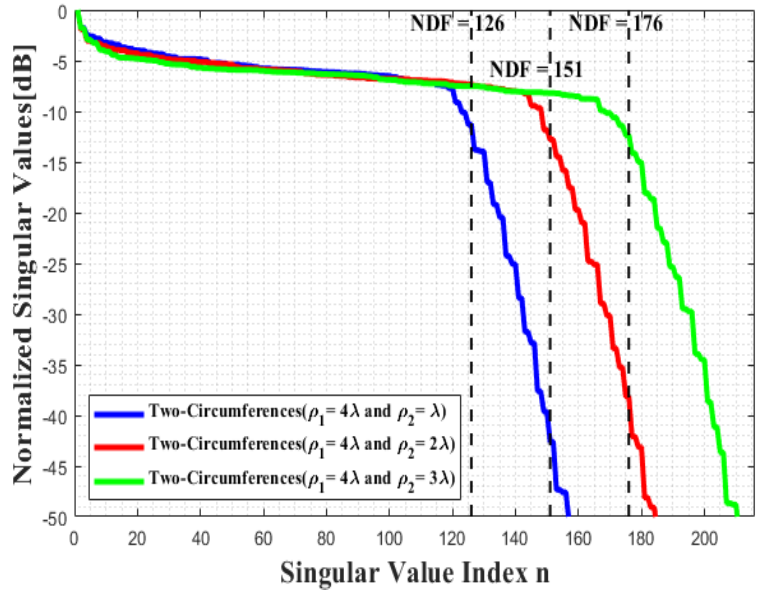
Figure 6. Comparison of the behavior of the normalized singular values of the linearized inverse scattering for two different circumferences cases.